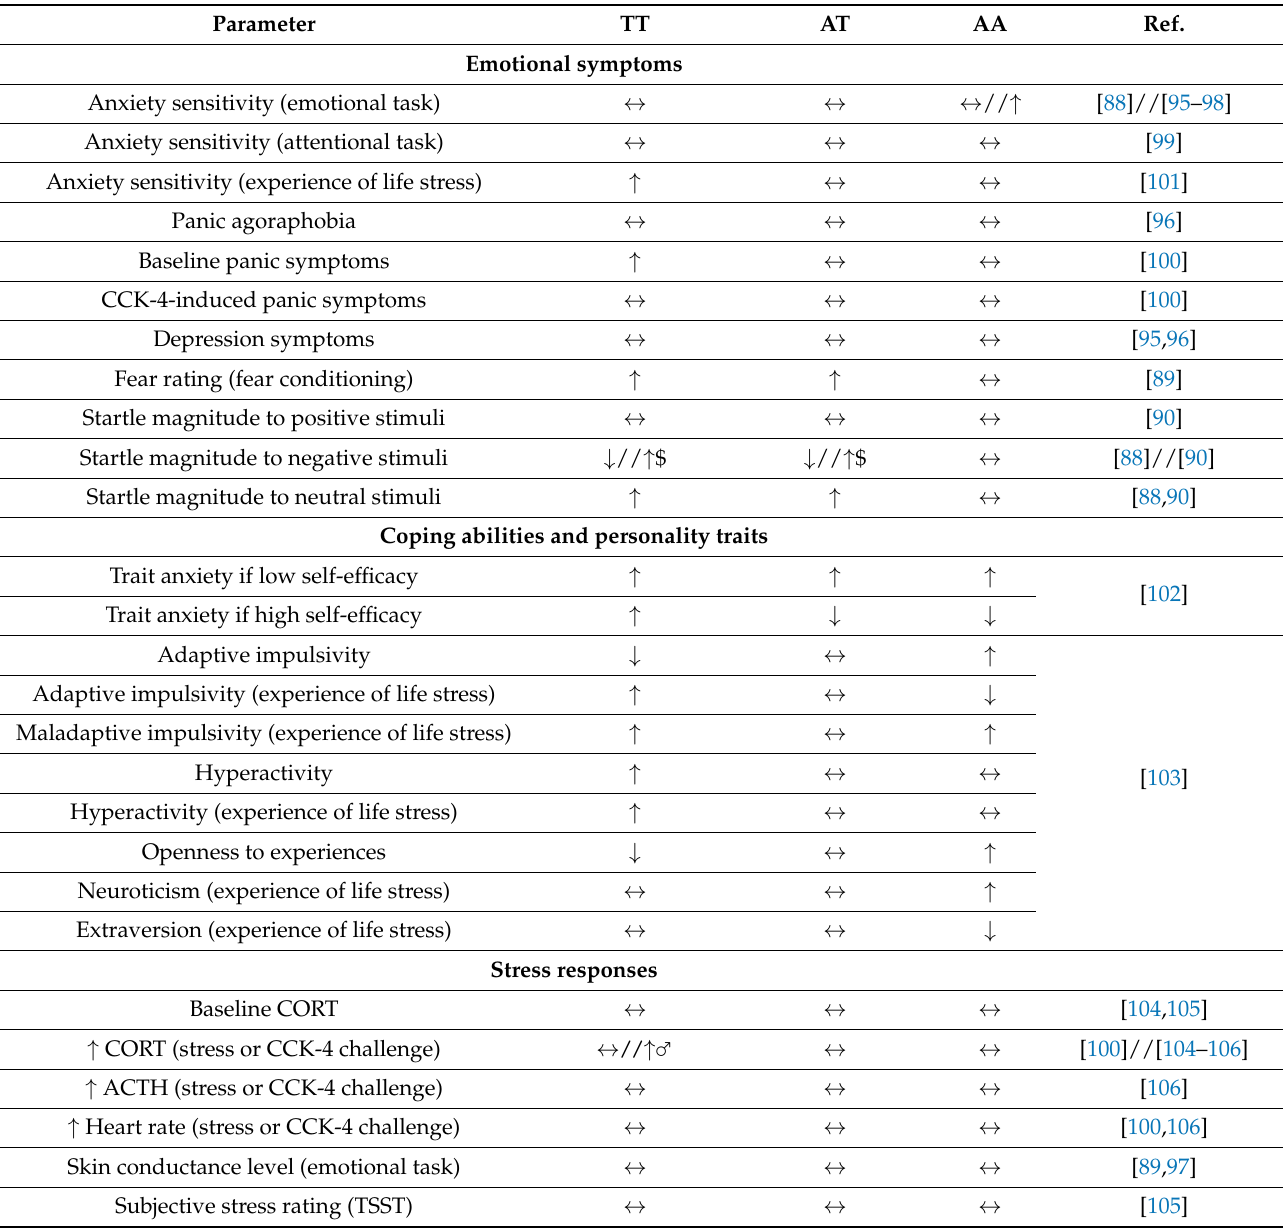
Table 4. Summary of the clinical studies showing the impact of the SNP rs324981 on emotional symptoms, coping abilities/personality and stress responses in healthy individuals. Parameter TT AT AA Ref. Emotional